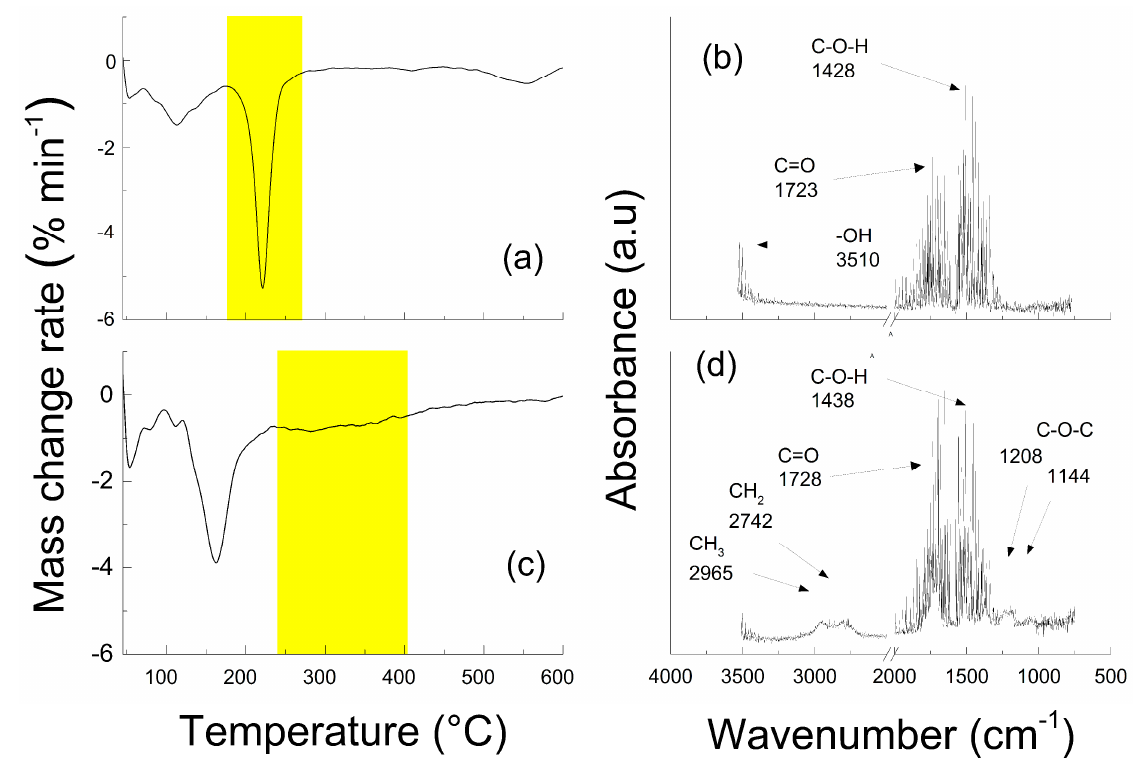
Figure 4. TGA spectra of neat GO ( a ) and GO-PBA hybrid particle ( b ) and corresponding FTIR evaluation during sample decomposition of neat GO ( c ) and GO-PBA ( d ). Yellow region representing the stage, when the FTIR signal was collected.